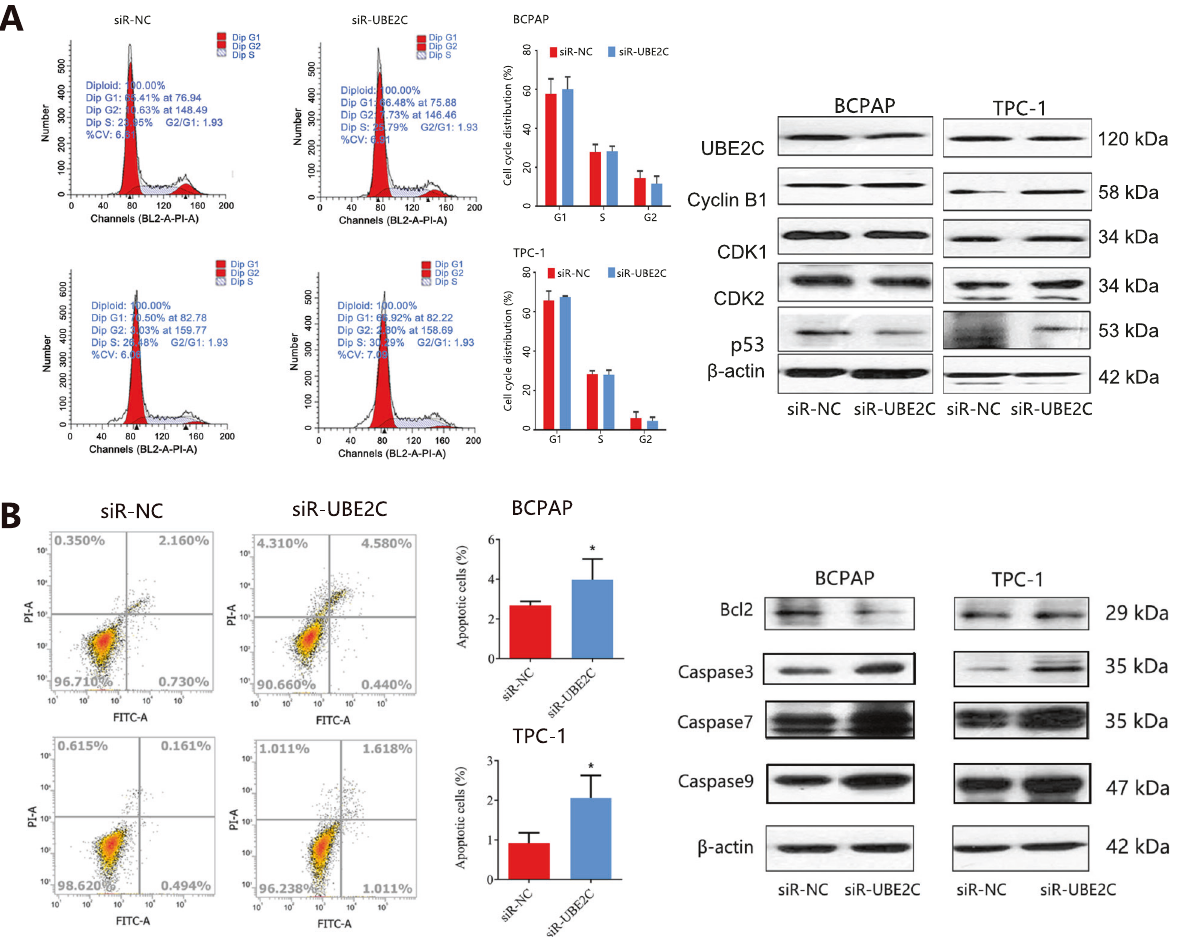
Fig. 5 The in fl uence of UBE2C knockdown on cell cycle distribution and apoptosis of THCA cell lines. A Cell cycle distribution analysis by fl ow cytometry and western blot. B Cell apoptosis analysis by fl ow cytometry and western blot. UBE2C ubiquitin-conjugating enzyme E2 C, THCA thyroid